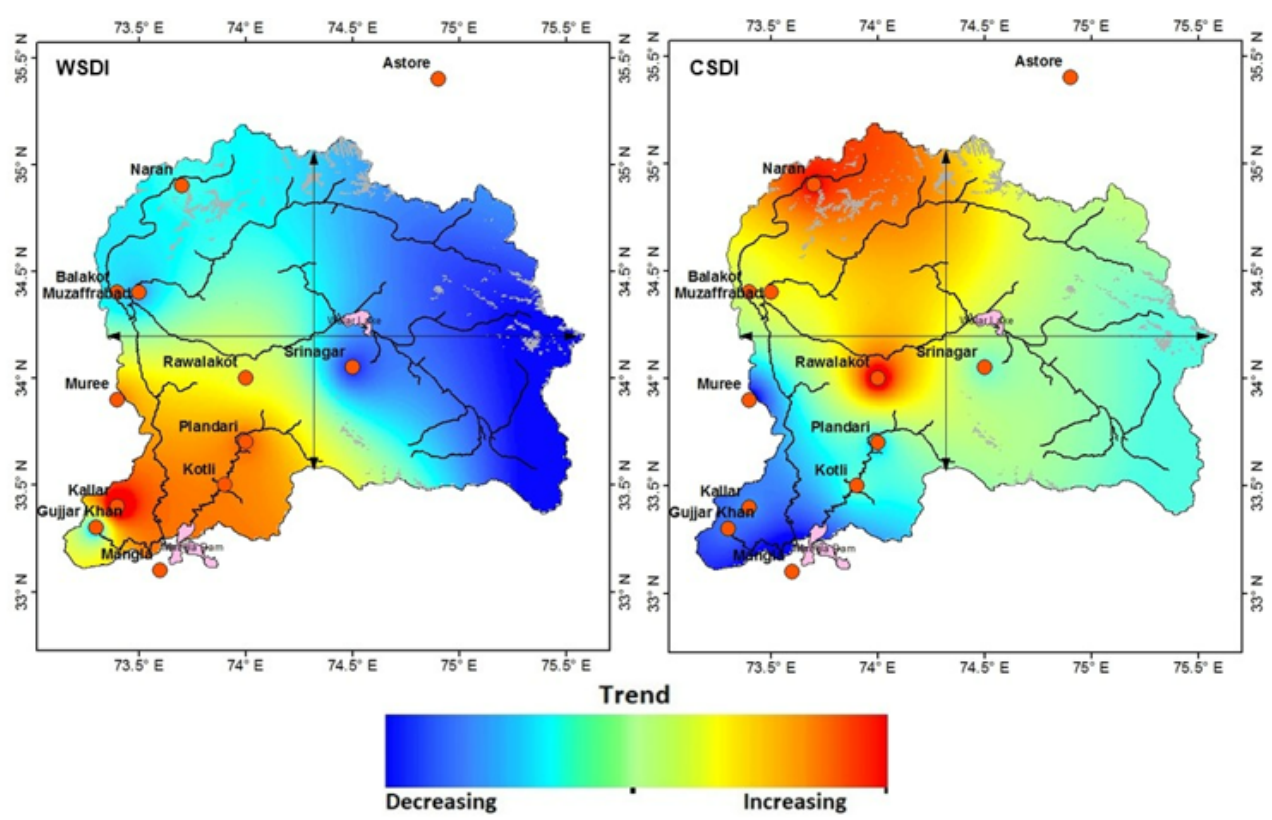
Figure 6. Spatial trends of warm spell duration (WSDI) and Cold spell duration CSDI. Table 7. Slopes and trends of cold and warm